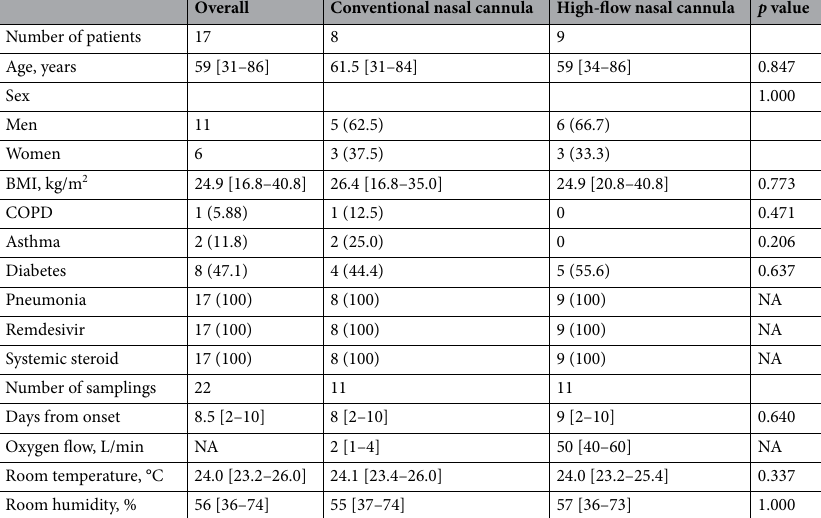
Table 1. Characteristics of the patients and samplings. BMI body mass index, COPD chronic obstructive pulmonary disease; and NA not applicable. Data are presented as number (%) or median [range].